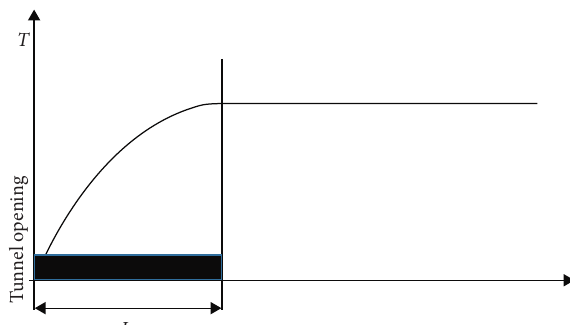
Figure 8: Design of the antifreeze disease fortification length in a tunnel.